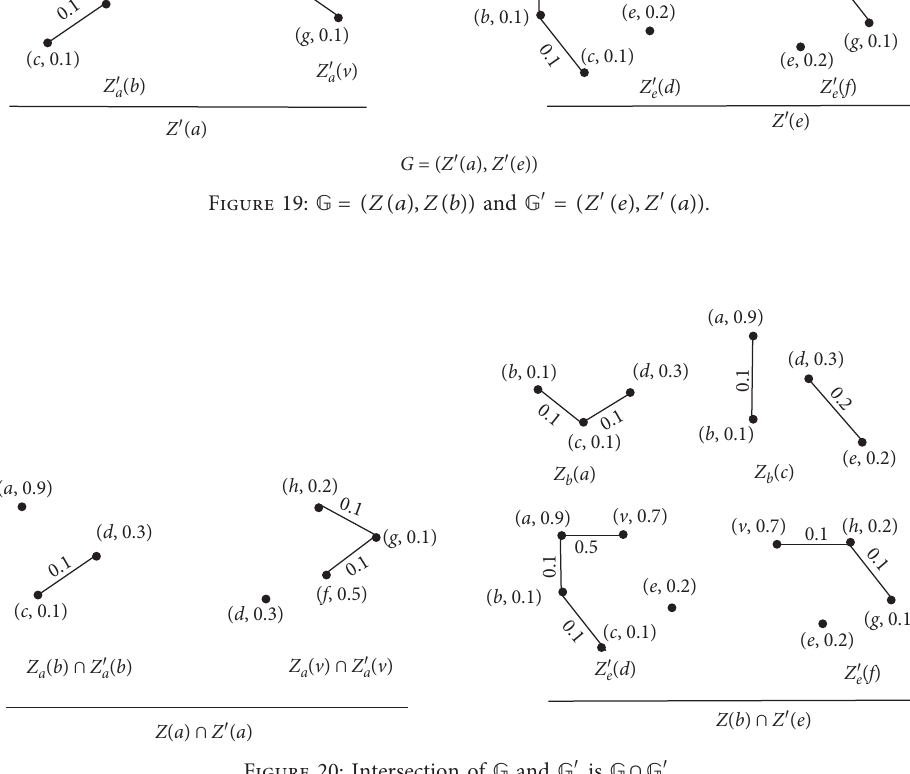
Figure 20: Intersection of G and G ′ is G ∩ G ′ .